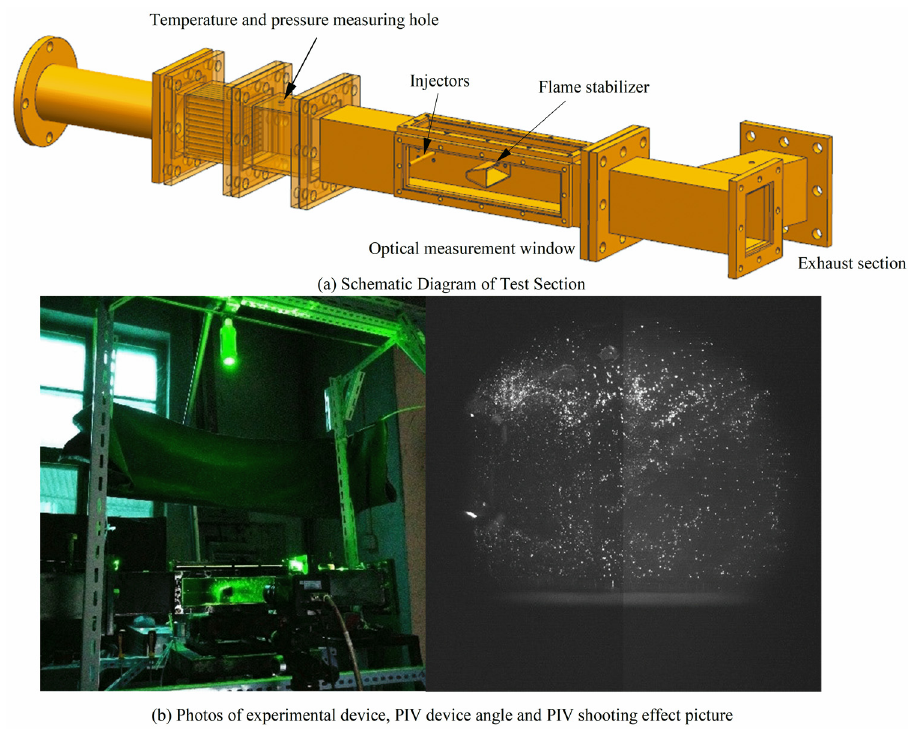
Figure 6. Schematic diagram of experimental section and photos of the experimental device. The laser generator, synchronizer, and CCD camera in the particle image velocimetry (PIV) system were used to shoot the spanwise section of aviation kerosene that was injected into the air crossflow with high temperature and low pressure. The PIV system was produced by Dantec Dynamics. The laser was a 566 nm dual optical path laser with a maximum operating frequency of 15 Hz, a pulse interval of 0.5 μs –50 ms, and a pulse width of 9 ns, which met the flow measurement requirements from low speed to high speed. The resolution of the CCD camera was 2048 × 2048. The CCD camera had very high light sensitivity. The fuel concentration field was characterized by small particles and weak reflection. The CCD camera captured the information of particles in the fuel concen- tration field. 3. Results and Discussion 3.1. Jet Trajectory This paper studied the parameters that affected the jet’s trajectory, including the in- flow velocity, inflow temperature, fuel supply pressure difference, nozzle diameter, and injection angle (Table 2). Considering the concept of controlling a single variable, we de- signed 20 working conditions that involved a variation range in the fuel–air momentum ratio (liquid–gas ratio) in the range of 19–74, and the variation range of Weber number within 149–587. Table 2. Calculation conditions of the parameters affecting the jet trajectory. Inflow Temperature (K)